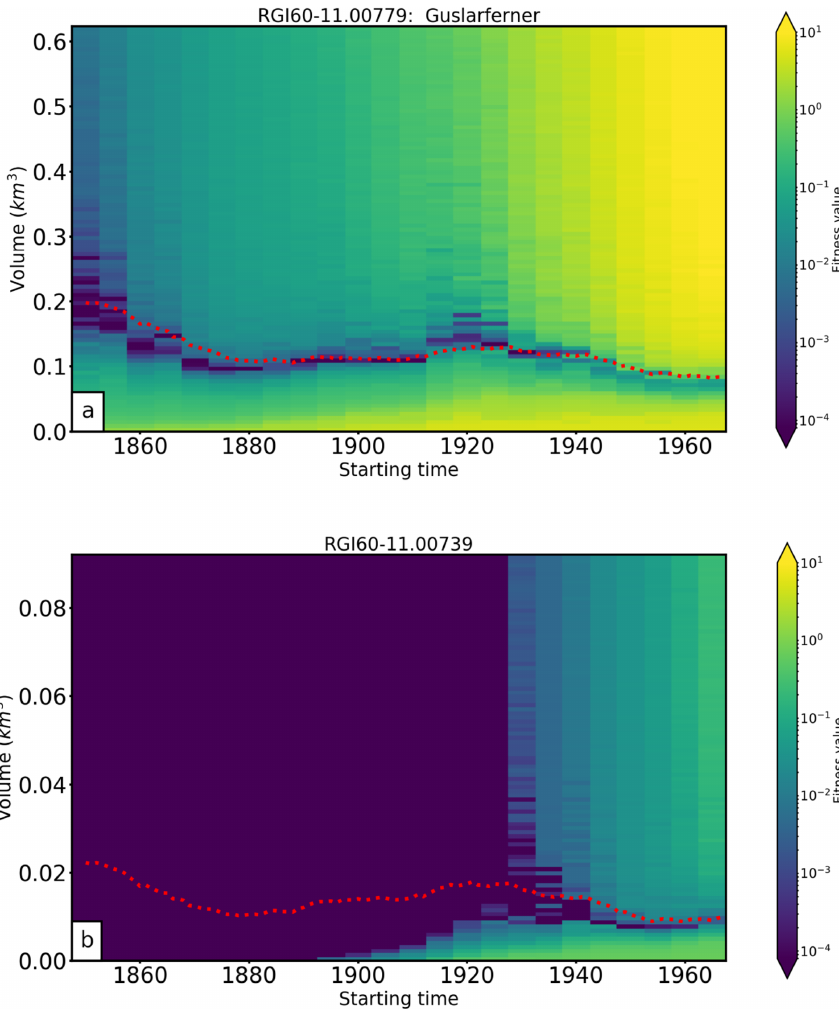
Figure B1. Reconstructability for different starting times. Colors indicate the fitness value of a simulation initialized with a glacier volume indicated by the vertical axis at a time indicated by the horizontal axis. Red dotted line shows the synthetic experiment. (a) Example for a glacier with ordinary reconstructive power; the “observed” glacier state in 2000 constrains the past evolution well in the 20th century, and the reconstruction is close to the goal. (b) Example for a glacier with very low reconstructive power; the “observed” glacier state does not constrain the past glacier evolution before approximately